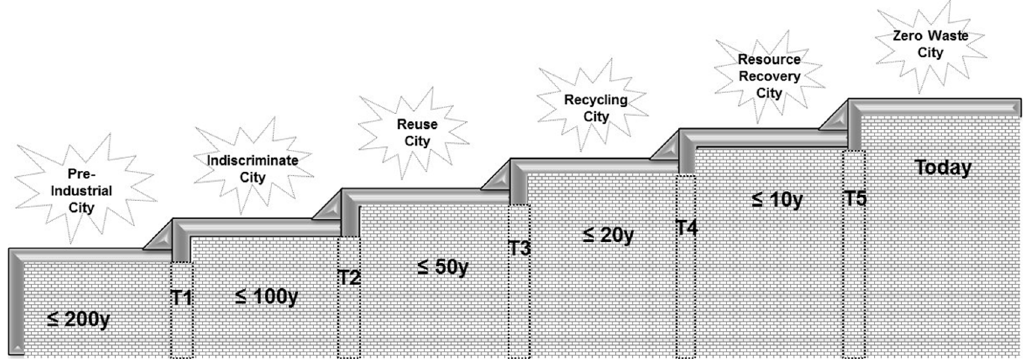
Fig. 5. MSWM transition stages for world economies. T = transition; y=